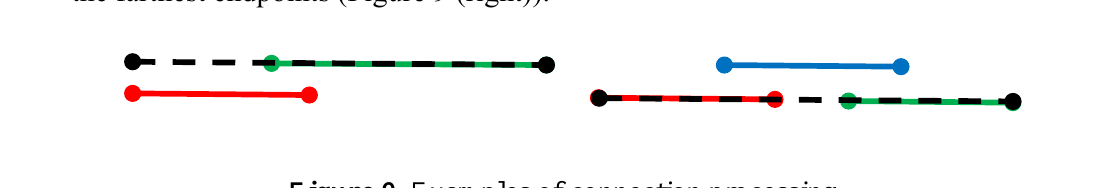
Figure 9. Examples of connection